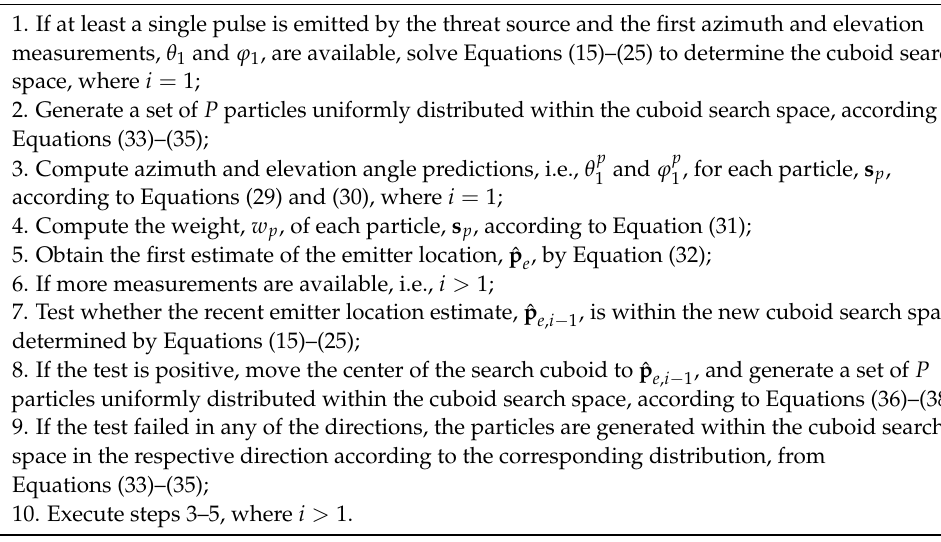
Algorithm 2. IPF algorithm for 3D emitter location using azimuth and elevation